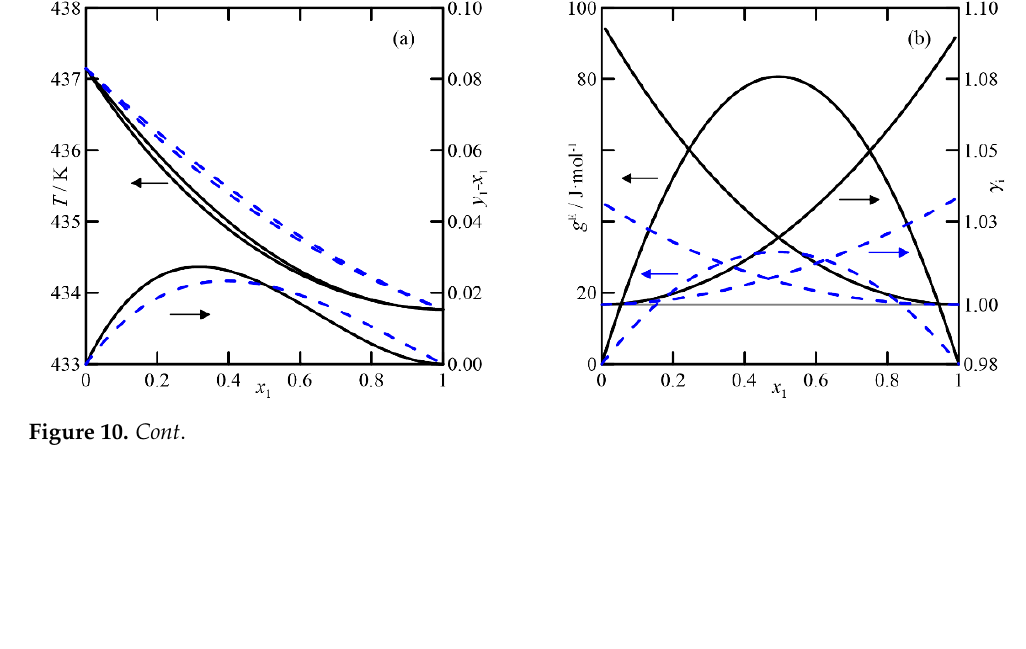
Figure 9. Estimations of VLE at 101.32 kPa of 2-methylcyclohexanone + cyclohexanol, (----) UNIFAC- DM; (- - -) COSMO-RS. (a) T ,x,y and (y − x ), x (b) γ i vs x and g E / RT vs x .